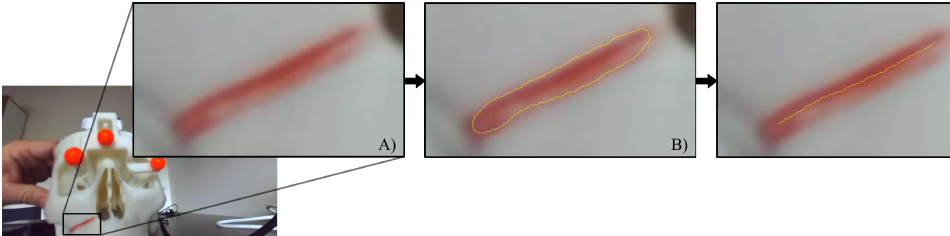
Figure 7. Feature detection on the real images: ( A ) Zoomed detail of the original real camera frame with the osteotomy line highlighted in red; ( B ) Result of the contour-based segmentation algorithm on the Hue-Saturation-Value colour space; ( C ) Final osteotomy center line detection.